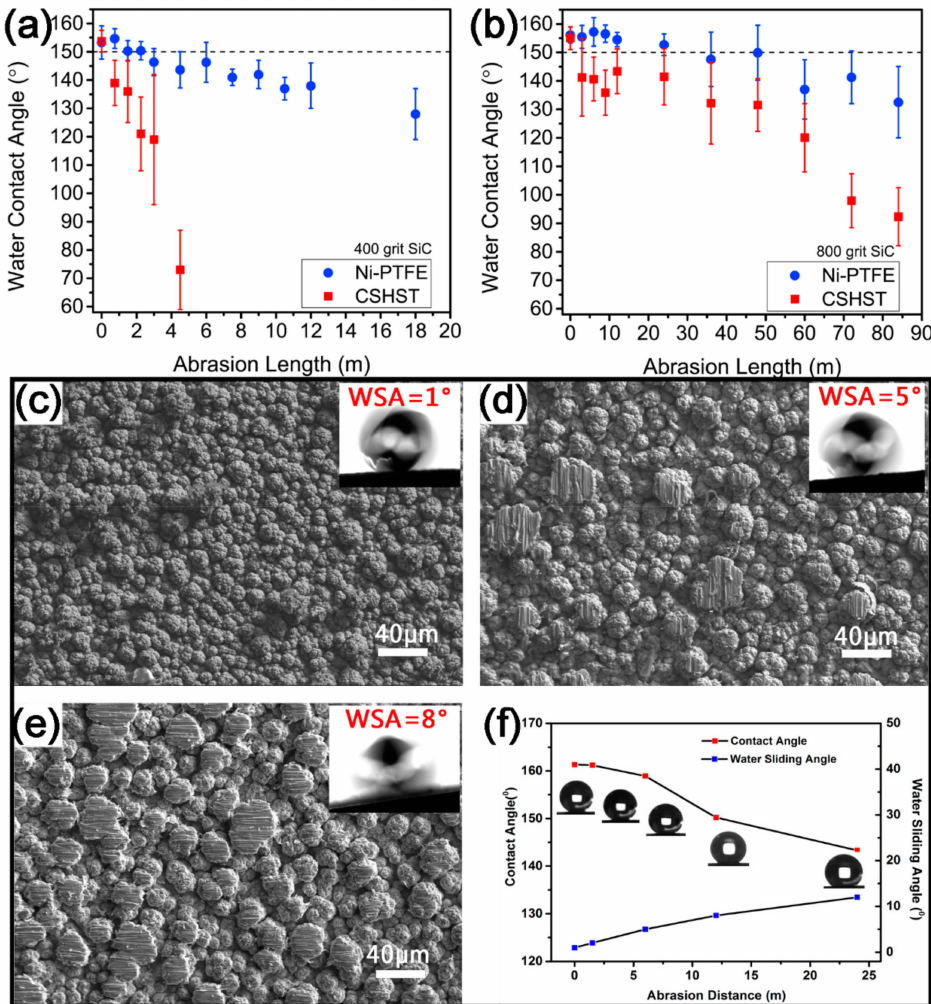
Figure 17. ( a , b ) E ff ect of abrasion length on WCA of Ni-PTFE composite coatings and CSHST coatings under 400 and 800 grit SiC papers, respectively. Reprinted from [95], Copyright (2017), with permission from Elsevier; ( c – e ) SEM images and inserted profiles of a water droplet for super-hydrophobic Co–Ni coating before abrasion and after abrasion wear of 6 m and 12 m under the applied pressure of 5 kPa, respectively; ( f ) Variations of the WCA and WSA on the tested surface with the abrasion distance [96]. Copyright (2019), with permission from MDPI